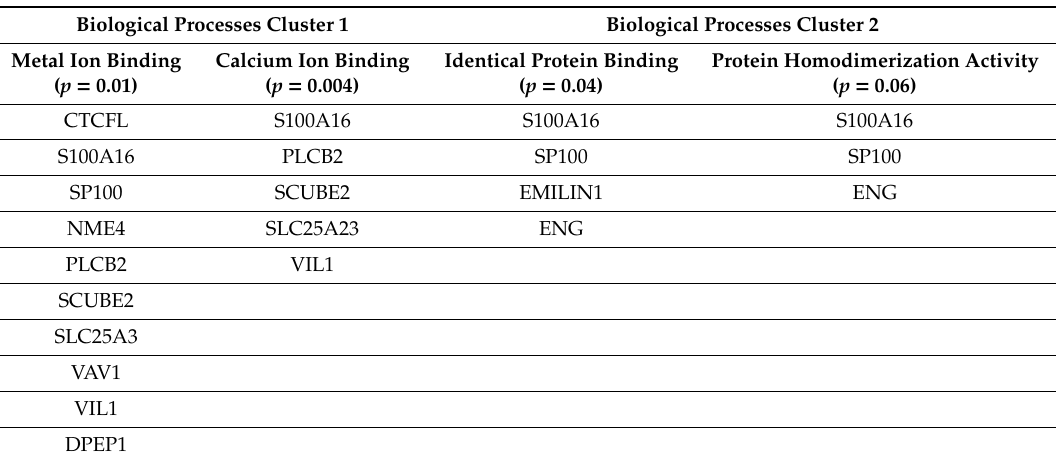
Table 5. DAVID clustering of biological processes of iM-forming genes with three or more 5hmCs within a G4 / iM-forming sequence downstream relative to TSS. The statistical significance of these processes being enriched versus random gene selection is indicated by the p value